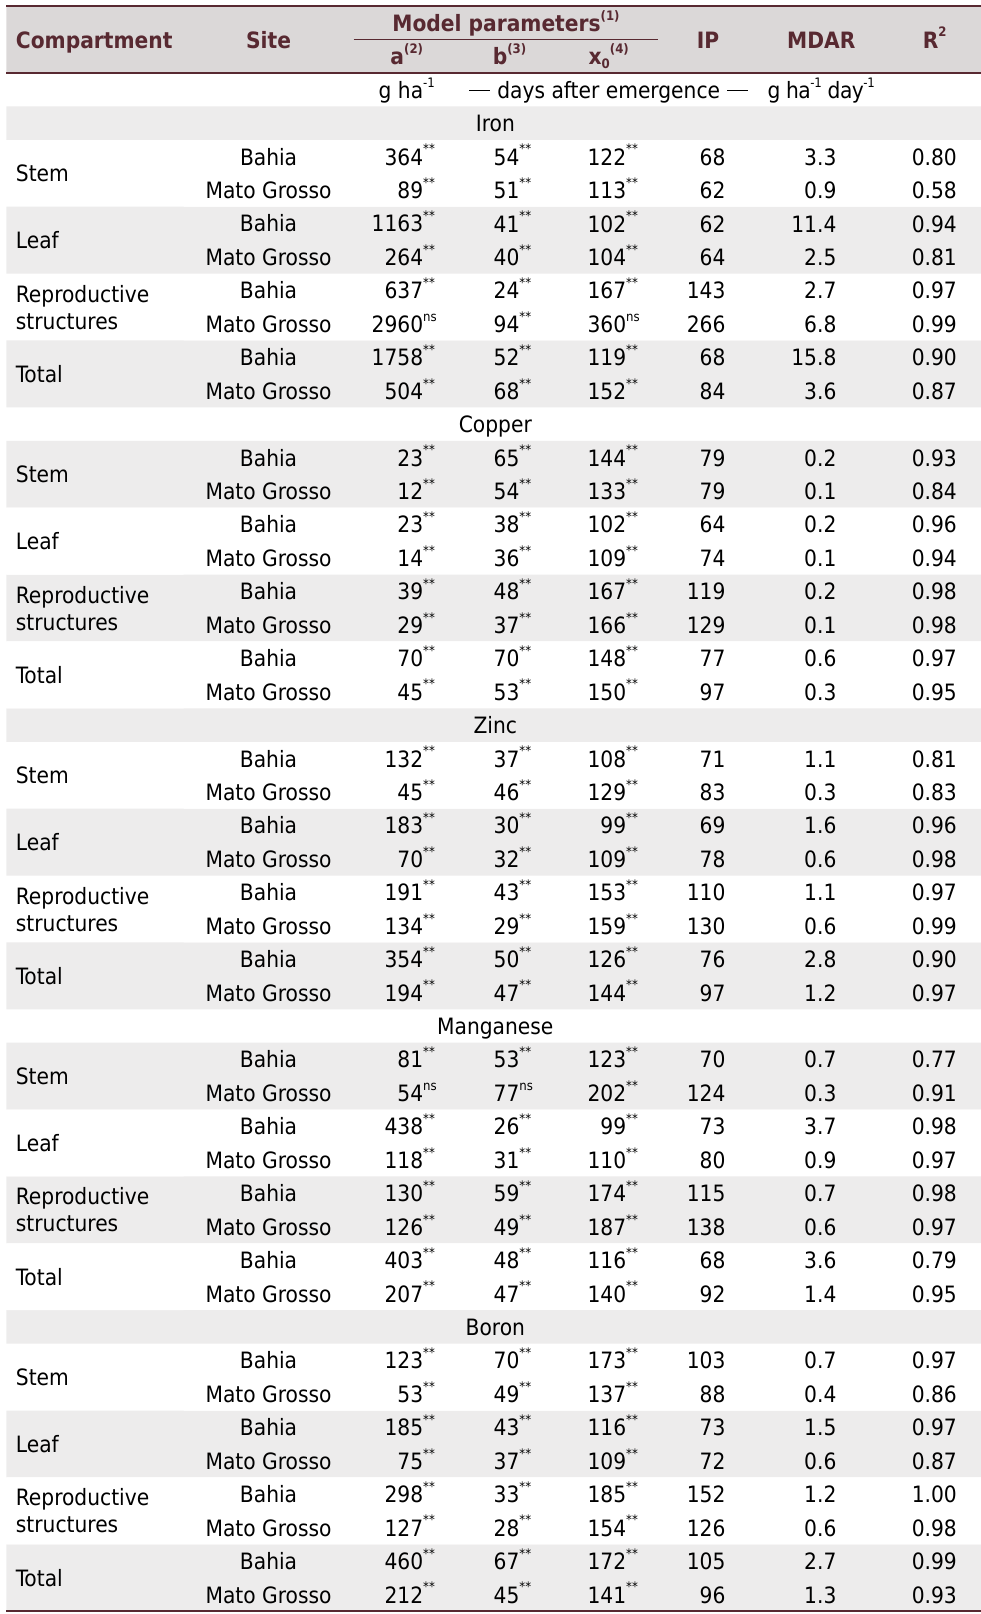
Table 4. Estimation of the model parameters fitted for accumulation of Fe, Cu, Zn, Mn, and B and respective inflection point (IP), maximum daily accumulation rate (MDAR), and coefficient of determination (R 2